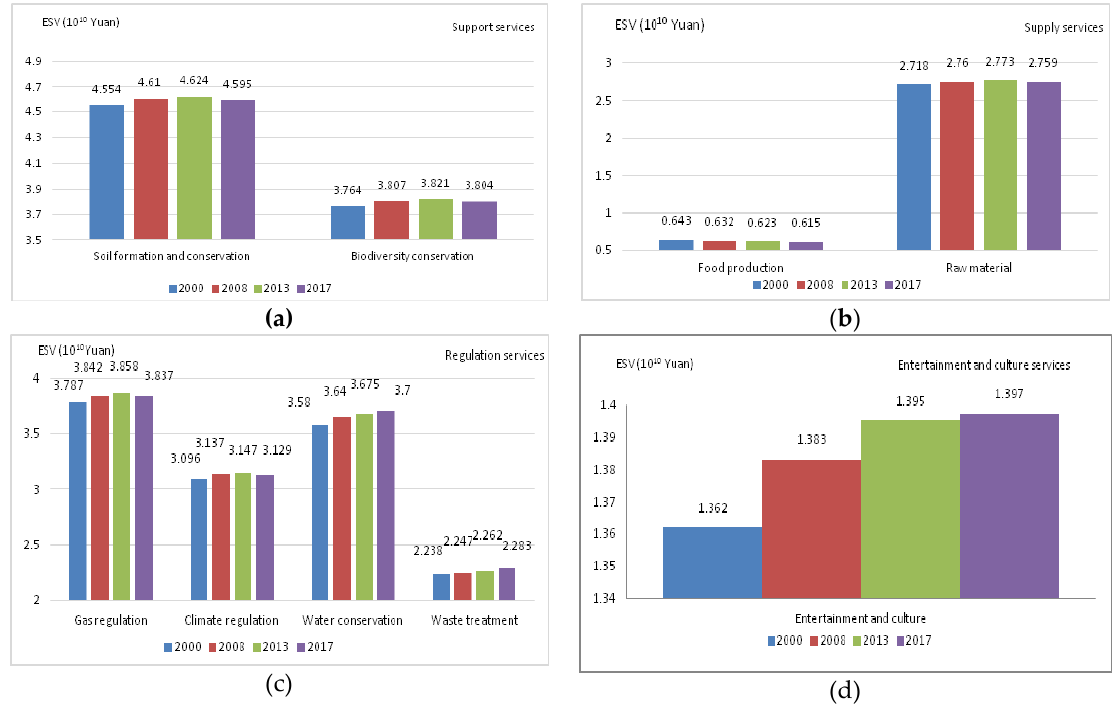
Figure 16. The ESV of various land cover types.